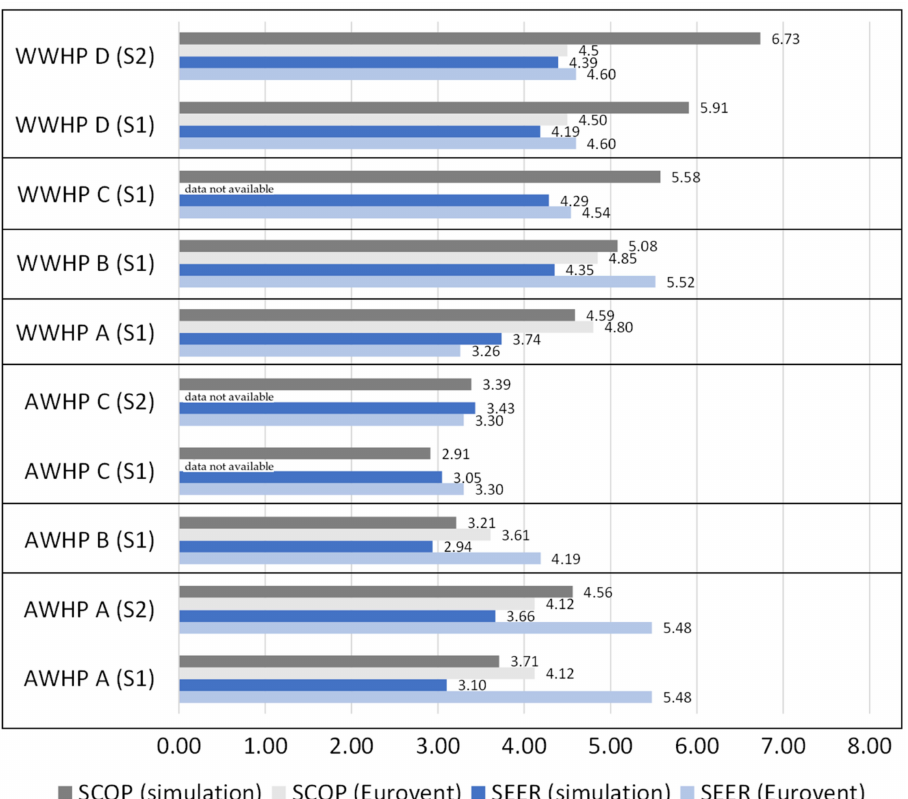
Figure 13. Comparison of seasonal efficiency indicators SCOP and SEER for AWHP and WWHP systems calculated from simulation results to values determined from Ref.